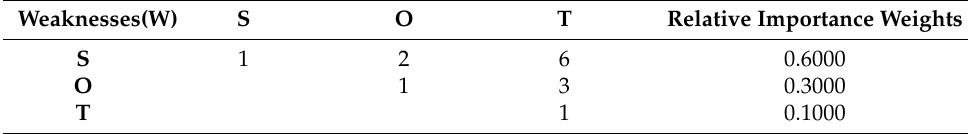
Table A5. The interdependence matrix of the SWOT factors with respect to “Weaknesses”.